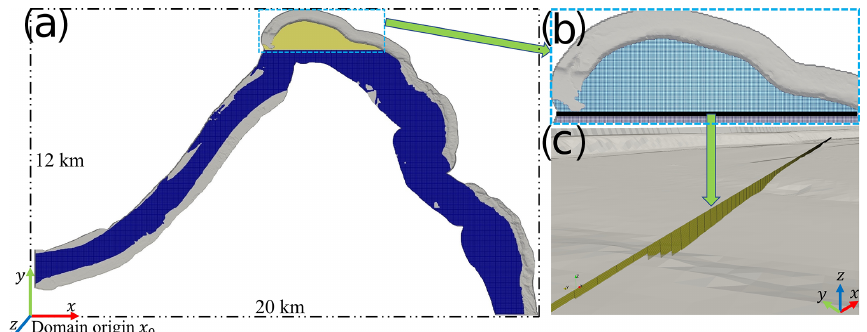
Figure 2. Horizontal and vertical computational meshes. (a) Top view showing the horizontal mesh over the whole domain. (b) Top view showing the details of horizontal mesh near LI. (c) 3-D view showing details of the vertical mesh